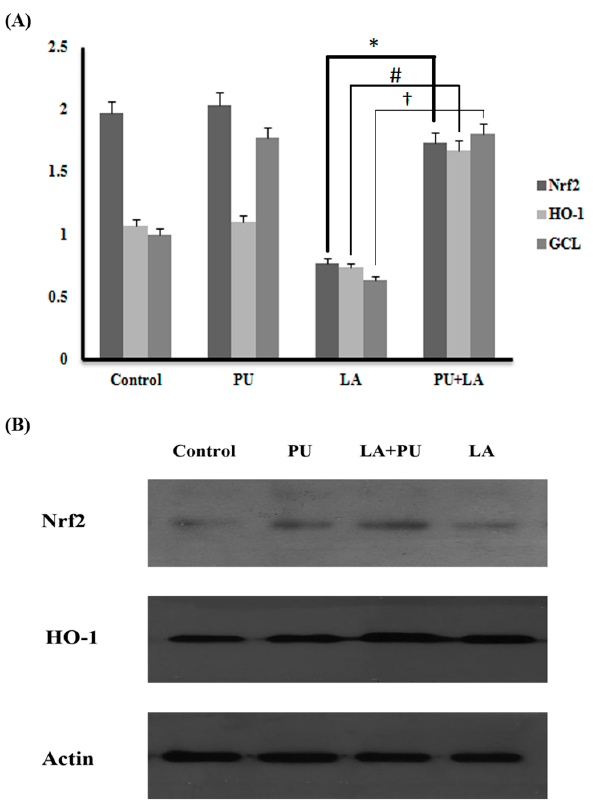
Figure 3. Nuclear factor (erythroid-derived 2)-like 2 (Nrf2) activation. ( A ) Real time reverse transcript-PCR was performed to detect expression of Nrf2 and its target genes heme oxygenase-1 ( HO-1 ) and glutamyl-cysteine ligase ( GCL ); ( B ) Western blot analysis results show Nrf2 and HO-1 increase in LA + PU. (*, #, † p < 0.0001 values compared for two groups).